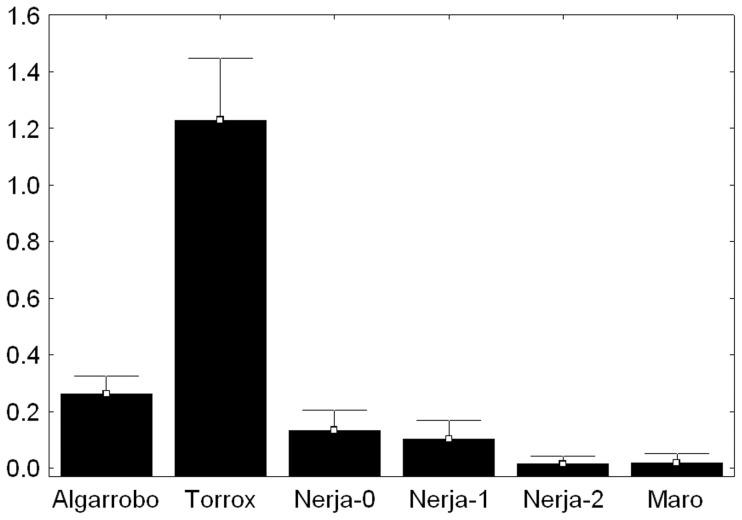
Mean frequency of B24 chromosomes in five localities near Torrox in Málaga province (Spain), showing how this B chromosome variant that emerged in Torrox is diffusing both eastward and westward.Populations are displayed from the west (Algarrobo) to the east (Maro). Frequencies were averaged per population including all year samples analyzed. Note that individuals can carry more than one B chromosome and thus mean B frequency can be higher than 1, as actually occurs in Torrox.